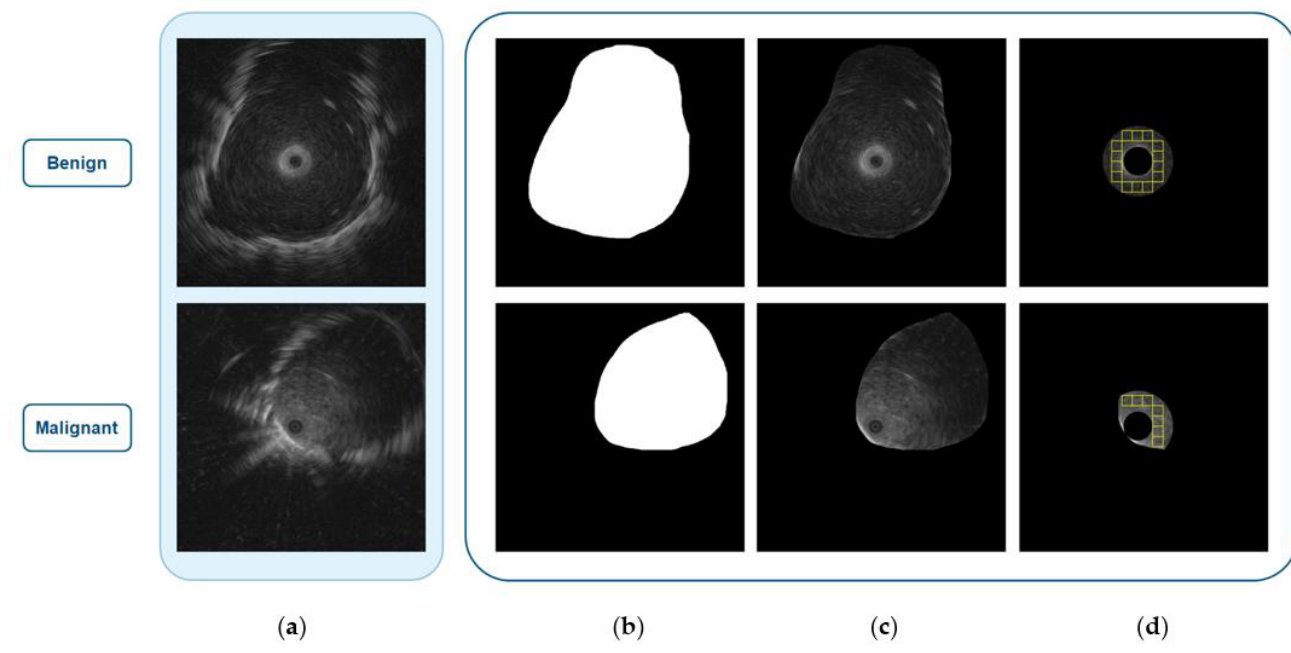
Figure 4. Results from the preprocessing step: ( a ) original images; ( b ) mask images; ( c ) regions of interest; ( d ) WOIs in the intersection area of the region of interest and the ring.